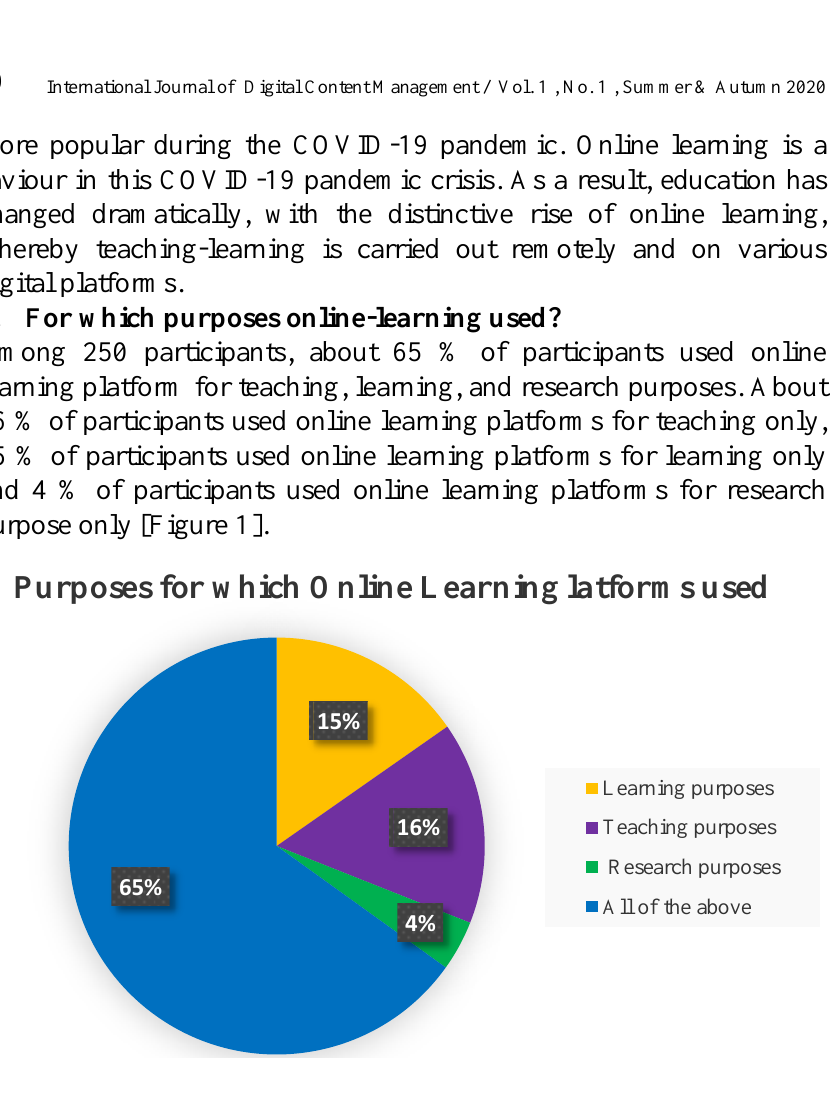
Figure - 1: Showing the purposes for which online learning platforms